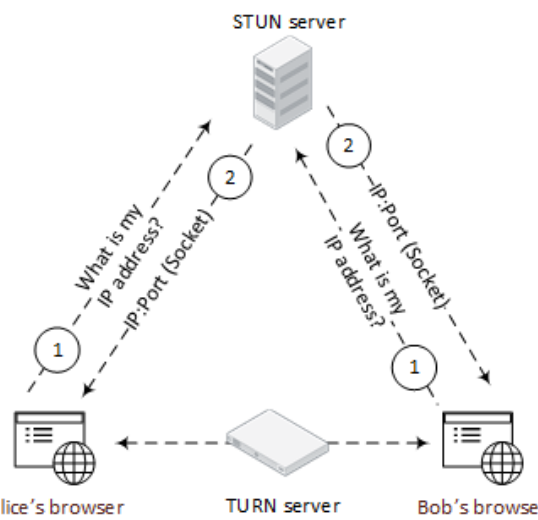
Figure 4. Using a TURN